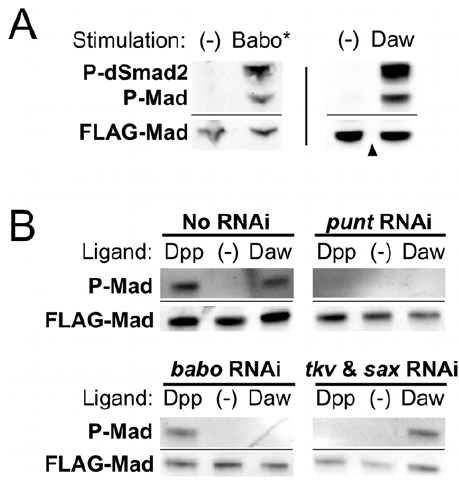
Figure 1. Stimulation of the Baboon receptor leads to phosphorylation of both R-Smads independently of BMP Type I receptors. S2 cells were transiently transfected with FLAG-tagged Smad expression constructs and analyzed by Western blot for C- terminal phosphorylation (P-dSmad2 and P-Mad). The FLAG-Mad band is shown as a loading control (FLAG-dSmad2 is not a useful loading control because of signaling-induced degradation as described later in the text). For all Western blot figures, a thin horizontal line indicates different infrared channels from the same blot. Co-expression of a constitutively active form of Baboon (Babo*) led to phosphorylation of dSmad2 and Mad (A, left blot). Exposure of cells expressing endogenous Baboon to the Dawdle ligand (Daw) had the same effect (A, right blot). RNAi treatment was used to determine receptor requirement for ligand activity (B). Controls confirmed that Dpp ligand treatment caused Mad phosphorylation independently of Baboon (B, left half). Dpp activity required the Punt Type II receptor and the Tkv and Sax BMP Type I receptors (B, right half). In contrast, Daw signaling to Mad required Baboon and Punt, but not Tkv and